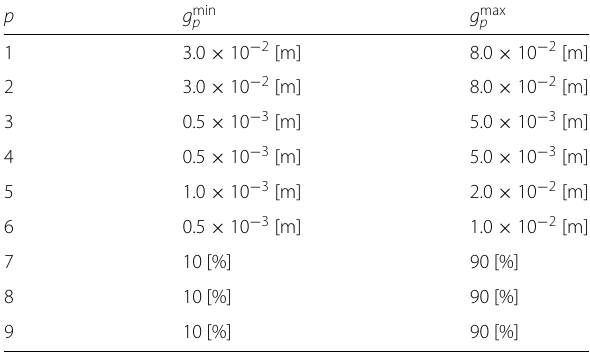
Table 2 SVR training. Definition of G